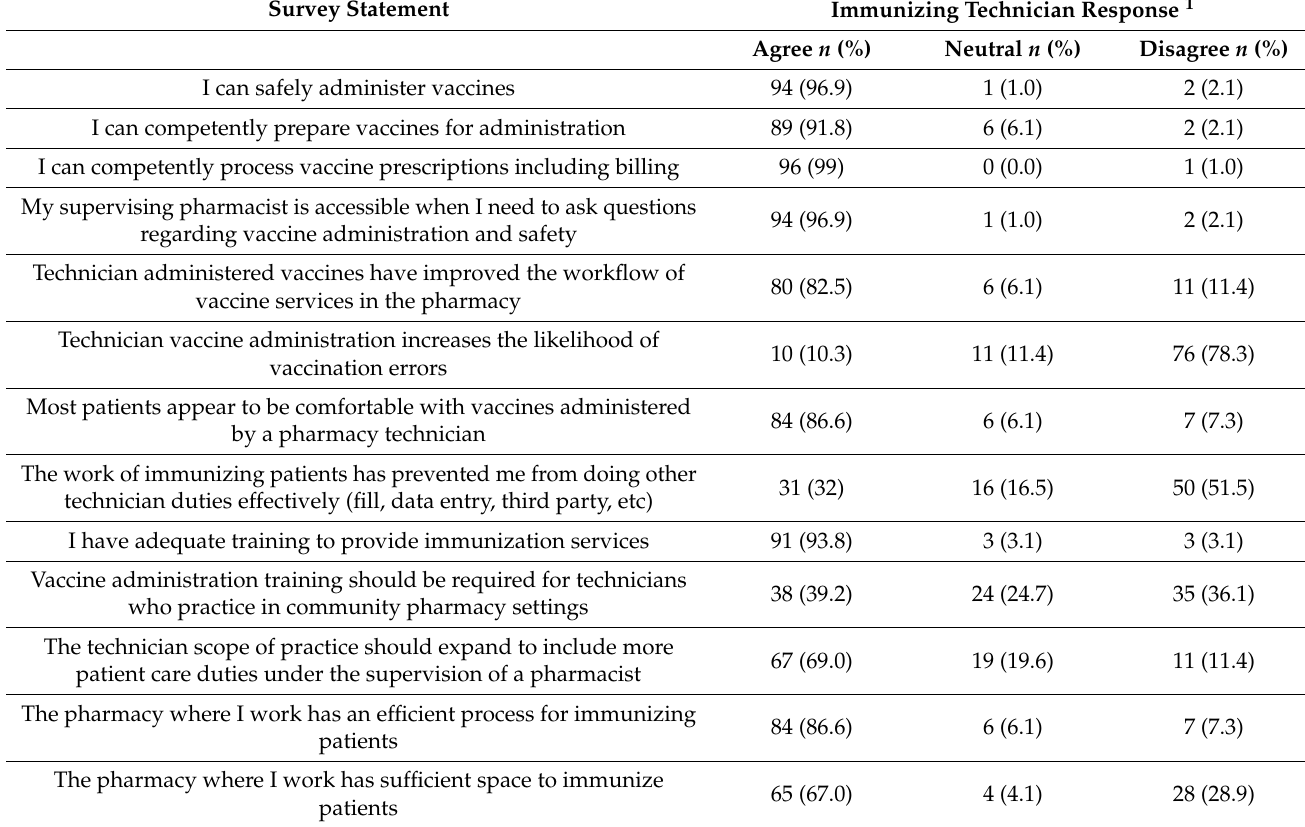
Table 4. Immunizing pharmacy technician survey response summary ( n =